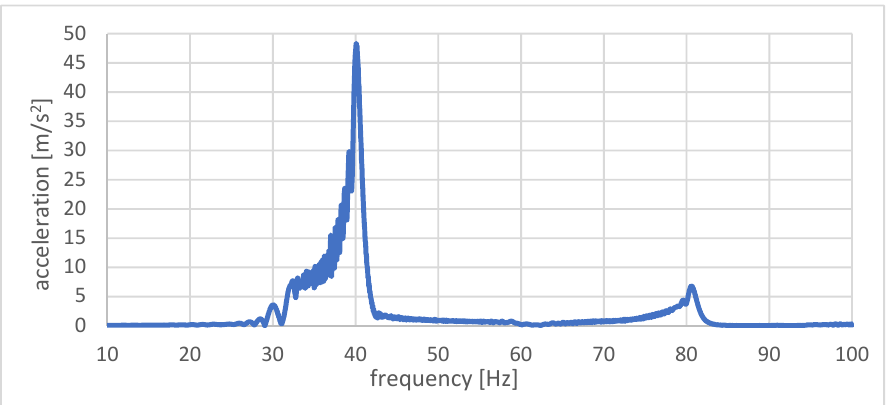
Figure 10. Example response measured with vibrometer at the end of the TW090_1 specimen (contact 40 mm + mass 7.6 g).